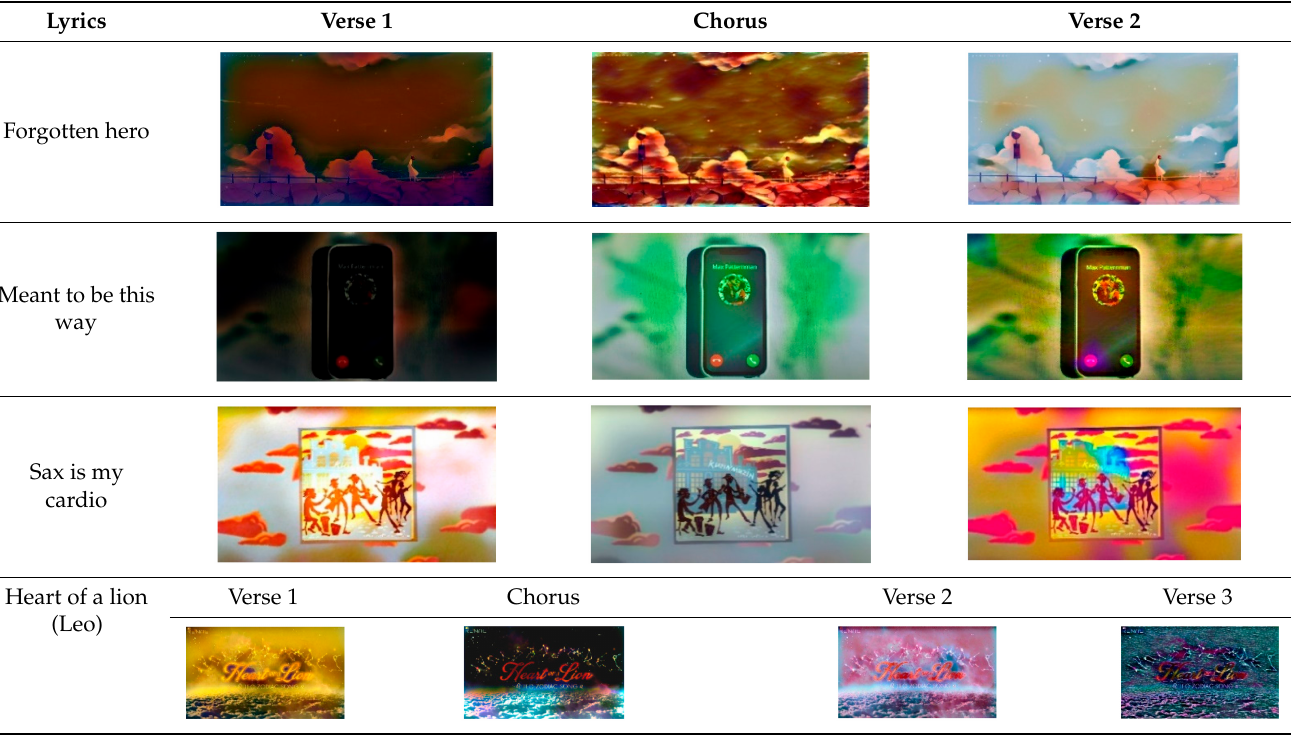
Table 7. Results of inputting various